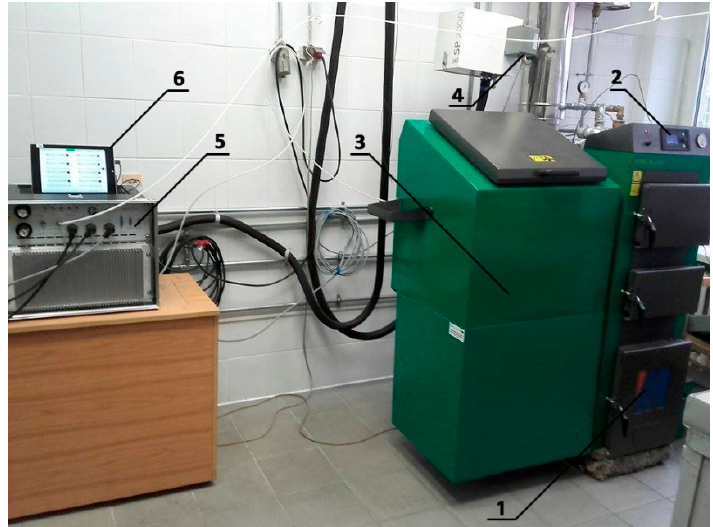
Figure 4. Laboratory stand at Low Emission Combustion Technologies: 1—Moderator Unica VentoEko boiler, 2—boiler controller, 3—fuel tank, 4—exhaust sampling, 5—MCA10 analyzer, 6—Microsoft tablet for archiving measurement results.